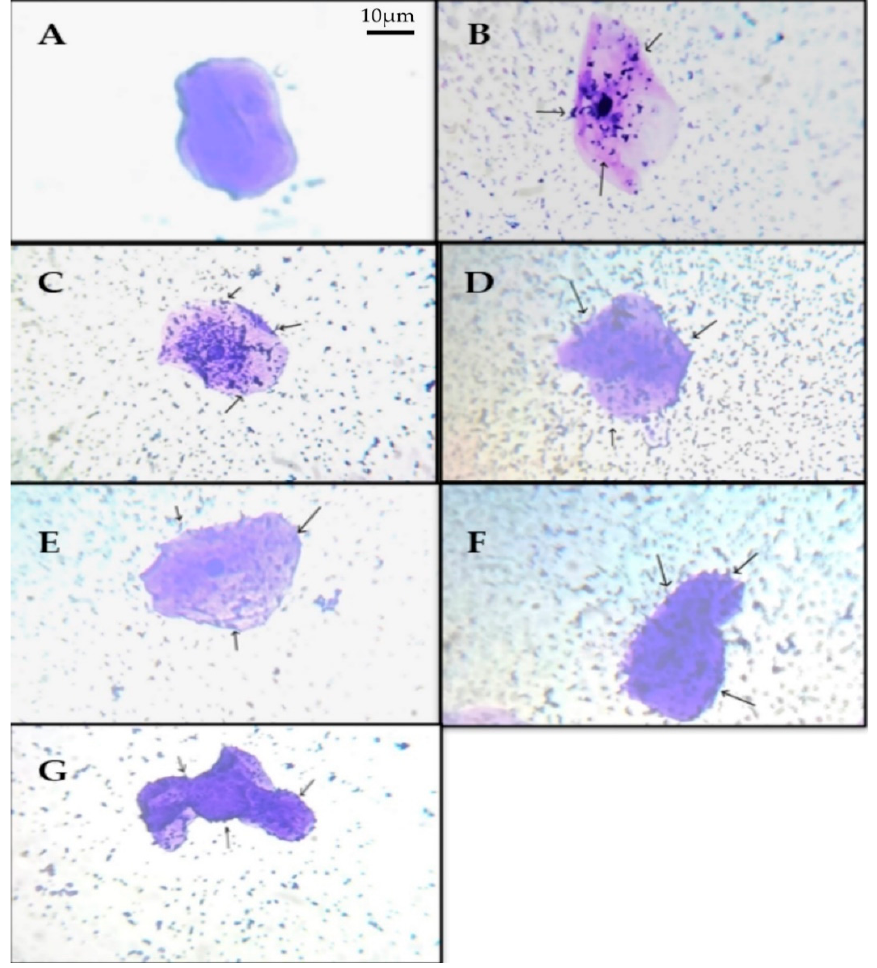
Figure 2. LAB strains adhesion to buccal epithelial cells observed under a light microscope. ( A ) Buccal epithelial cells (control). ( B ) The adhesion of isolate: RAMULAB07 ( B ), RAMULAB08 ( C ), RAMULAB09 ( D ), RAMULAB10 ( E ), RAMULAB11 ( F ), and RAMULAB12 ( G ) to buccal epithelial cells. Note: the black arrow shows the LAB strains attached to the epithelial cells. Table 4. Adhesion expressed in percentage of the isolates adhering to HT-29 cells.